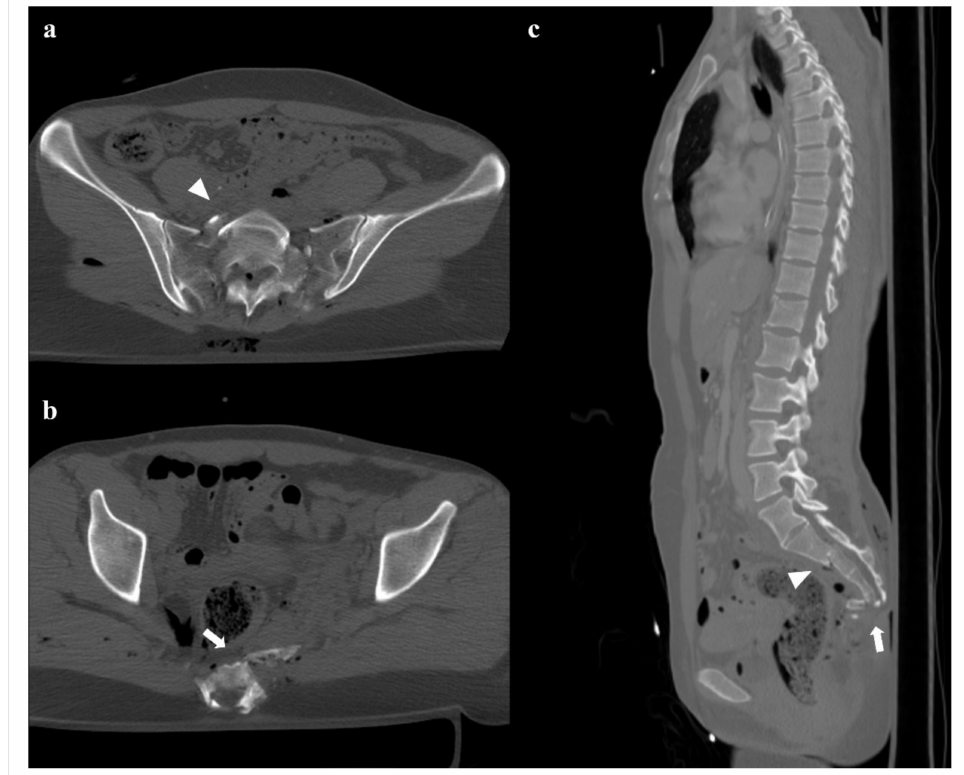
Figure 8. Fractures of the sacrum with involvement of the central canal. Fracture through S2, with anterior angulation of the superior fragment and without dislocation (arrowheads in ( a , c )). Fracture of S4 with complete anterolisthesis of the fragments (arrows in ( b , c )). There are also some bubbles of air in the adjacent soft